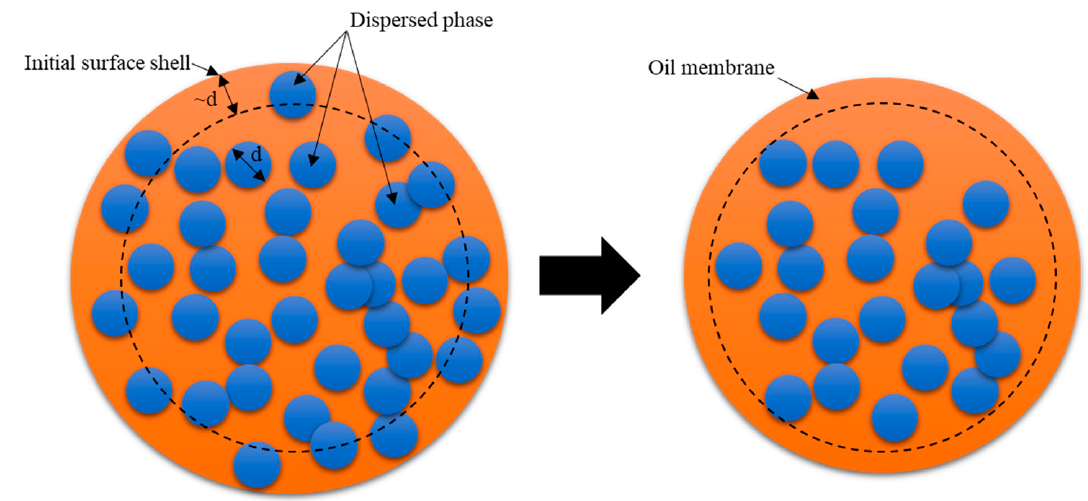
Figure 4. Sketch of the initial surface shell and formation of the oil membrane (adopted from [85]).